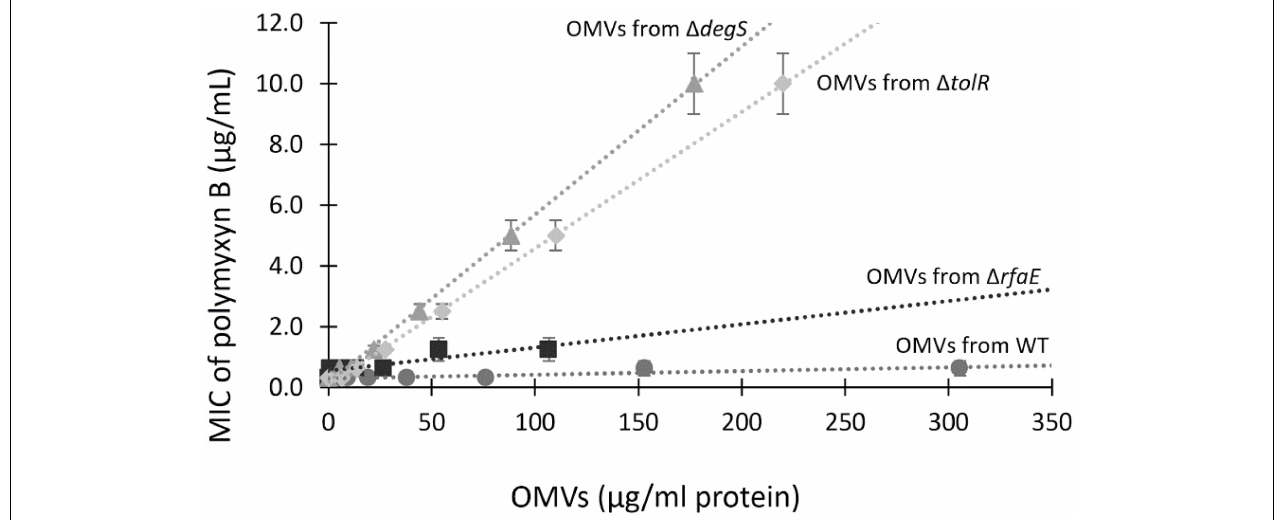
FIGURE 3 | The MIC of polymyxin B depends on the concentration of OMVs. MIC of polymyxin B for S. Typhi WT was determined in the presence of different known concentrations of OMVs. Linear trend lines are represented by dotted lines ( n = at least 4; bars represent the standard error).